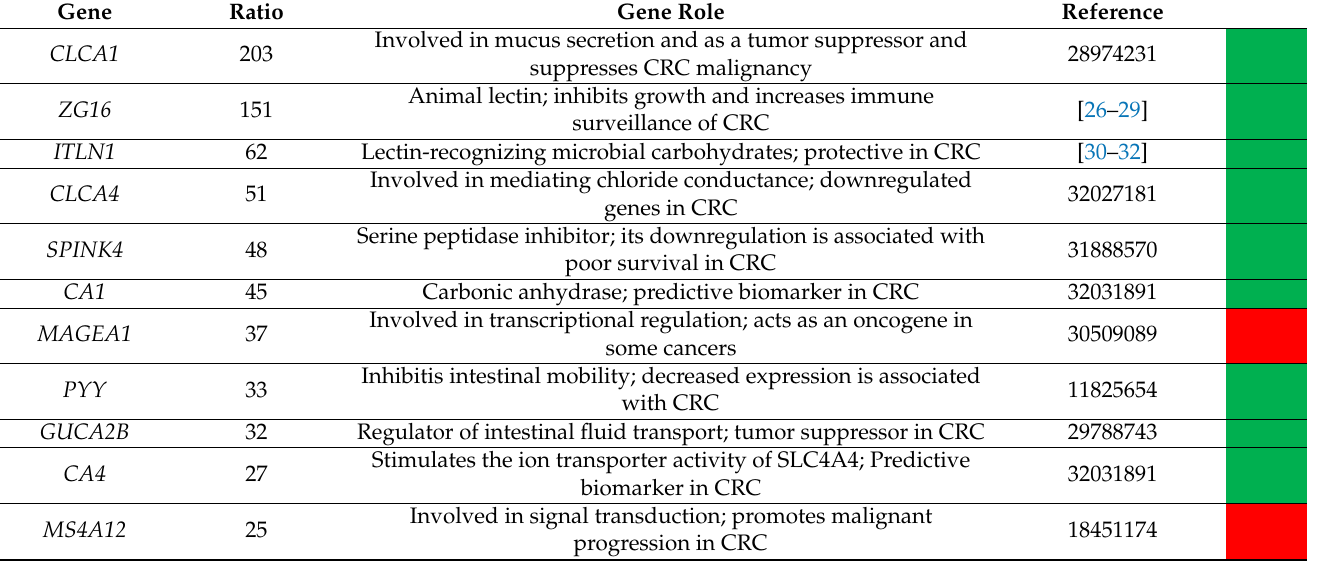
Figure 3. Schematic representation of the TCGA data analysis. The 626 COADREAD cases were ordered according to the level of B4GALNT2 expression, differentiating the 15% top expression (HBE, red) and the 15% lower expression (LBE, blue) cohorts of 94 cases. Statistical analysis (false discovery rate two-stage linear step-up procedure of Benjamini, Krieger, and Yekutieli) revealed that 614 genes were differentially expressed in the two cohorts. Of these, 451 genes were more expressed in HBE while 163 were more expressed in the LBE. Table 1. Genes differentially modulated in HBE and